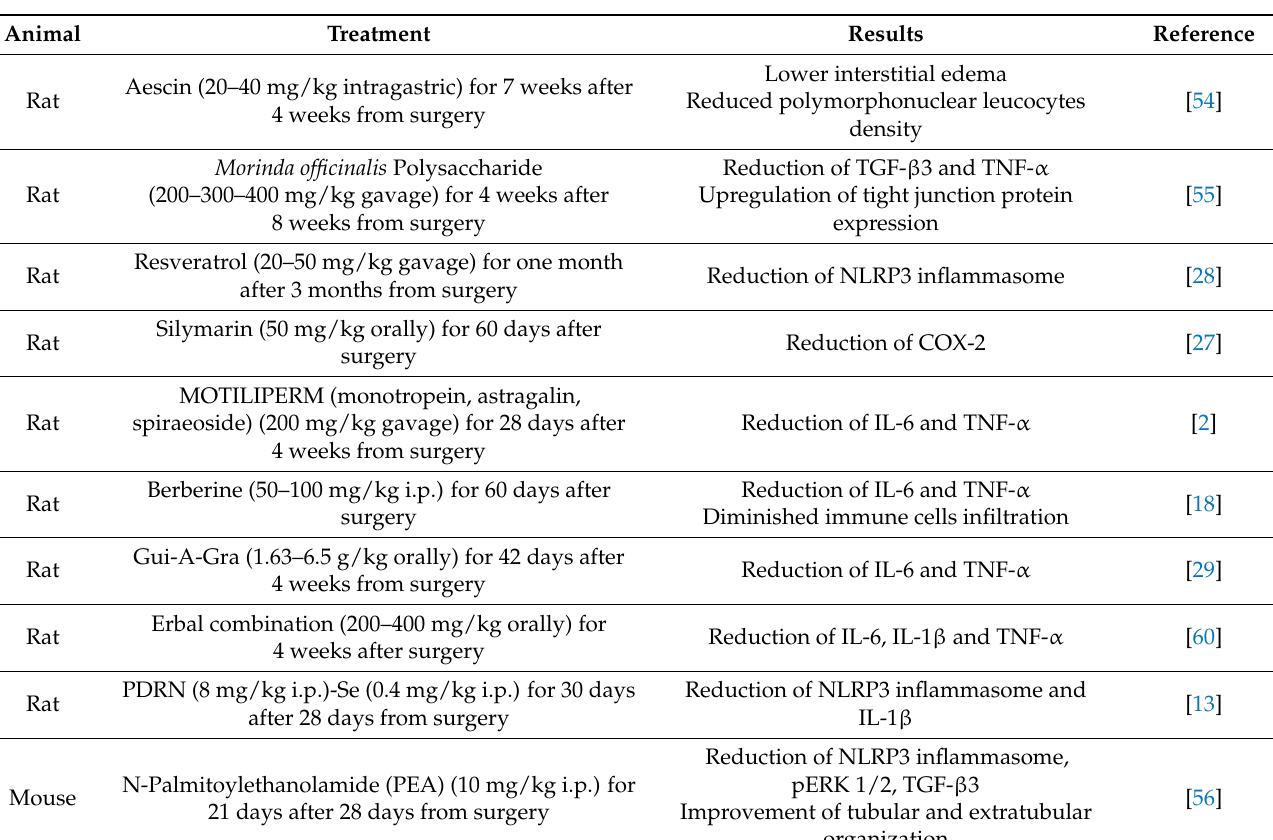
Table 1. Anti-inflammatory approaches in experimental